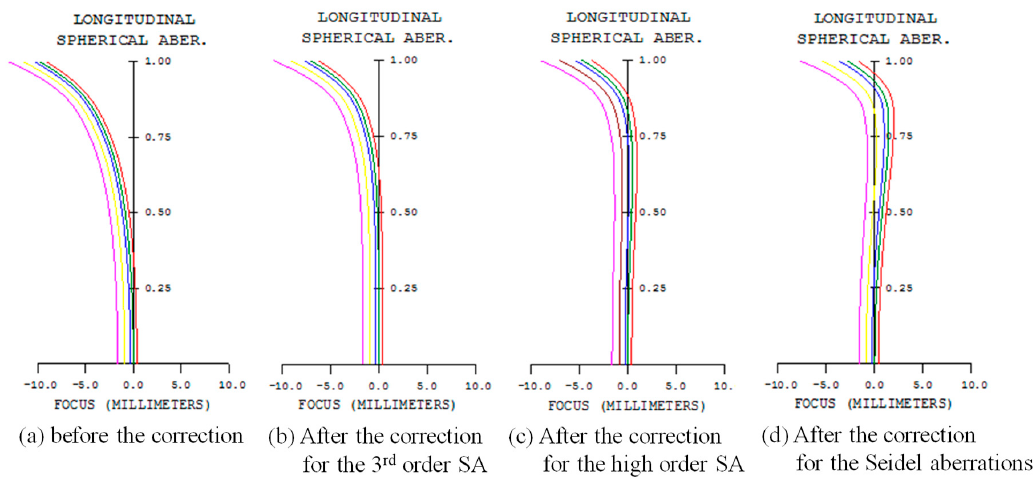
Table 4. First orders of basic design.